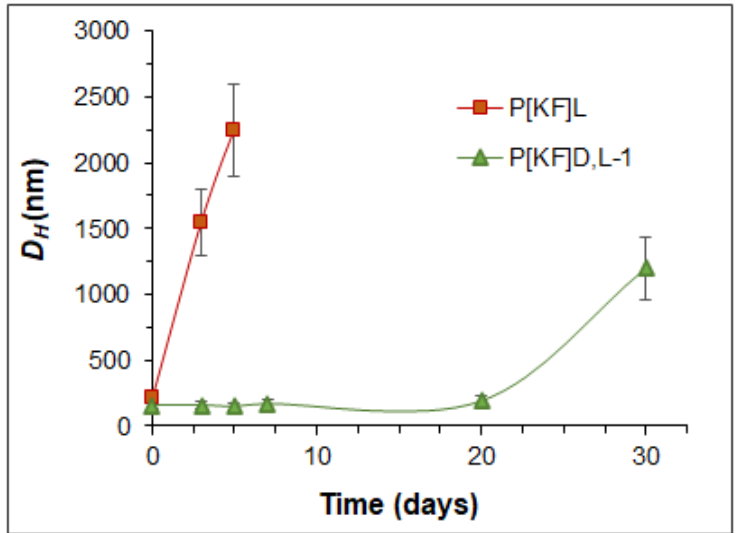
Figure 1. Stability of nanoparticles under simulated physiological conditions (PBS, pH 7.4, contain- ing papain, 37 °C): P[KF] L nanoparticles with initial D H of 200 ± 20 nm; P[KF] D,L nanoparticles with initial D H of 110 ± 10 nm.